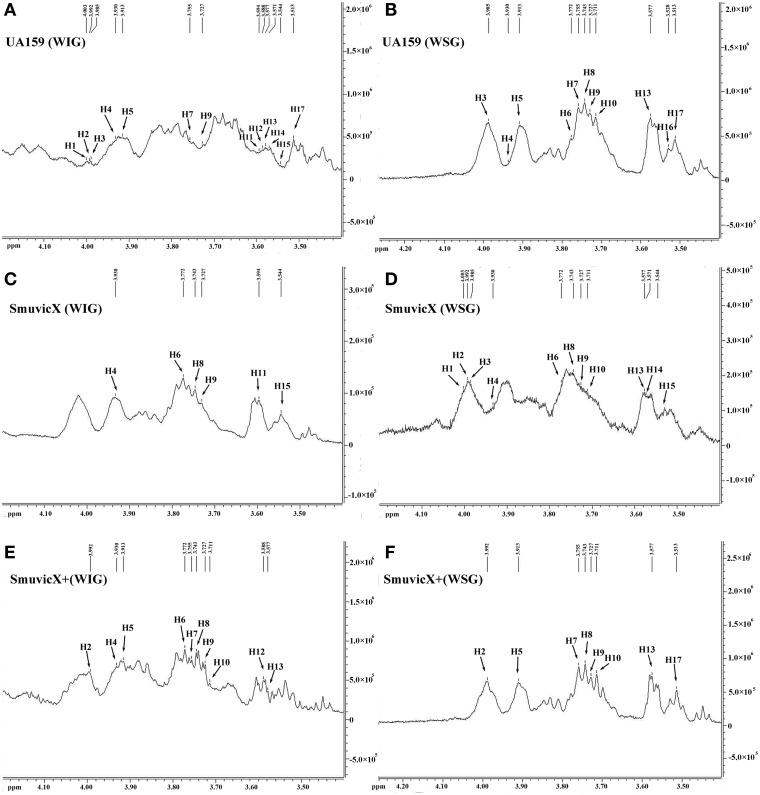
The structural properties of the glucan of S. mutans biofilms were further elucidated using 600 MHz 1H nuclear magnetic resonance (NMR) spectroscopy. Several sharp well-resolved peaks corresponding to the dextran standard metabolites could be observed in each of the strains. The 1H NMR spectrum of the water-insoluble glucan (WIG) of the UA159 strain consisted mostly of signals at 4.003, 3.992, 3.985, 3.9301, 3.913, 3.755, 3.727, 3.594, 3.588, 3.577, 3.571, 3.544, and 3.513 ppm (A); the 1H NMR spectrum of the water-soluble glucan (WSG) of the UA159 strain consisted mostly of signals at 3.985, 3.9301, 3.913, 3.772, 3.755, 3.743, 3.727, 3.711, 3.577, 3.528, and 3.513 ppm (B); the 1H NMR spectrum of the WIG of the SmuvicX strain consisted of lesser signals at 3.930, 3.772, 3.743, 3.727, 3.594, and 3.544 ppm (C); the 1H NMR spectrum of the WSG of the SmuvicX strain consisted of signals at 4.003, 3.992, 3.985, 3.930, 3.772, 3.743, 3.727, 3.711, 3.577, 3.571, and 3.544 ppm (D); the 1H NMR spectrum of the WIG of the SmuvicX+ strain consisted of signals at 3.992, 3.930, 3.913, 3.772, 3.755, 3.743, 3.727, 3.711, 3.588, and 3.577 ppm (E); and the 1H NMR spectrum of the WSG of the SmuvicX+ strain consisted of signals at 3.992, 3.913, 3.755, 3.743, 3.727, 3.711, 3.571, and 3.544 ppm (F).